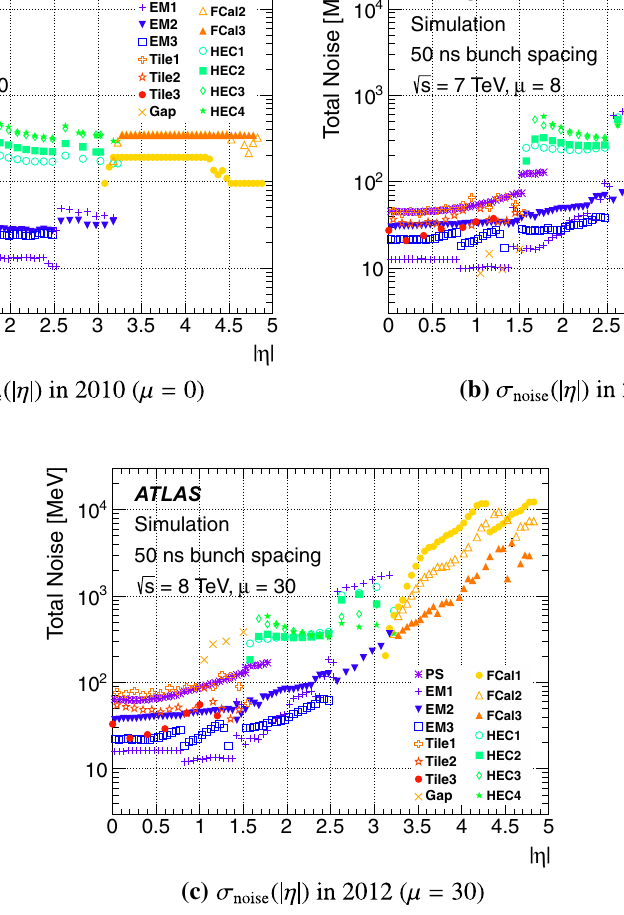
Fig. 4 The energy-equivalent cell noise in the ATLAS calorimeters on the electromagnetic (EM) scale as a function of the direction | η | in the detector, for a the 2010 configuration with μ = 0, b the 2011 configura- tionwith μ = 8(bothplotsfromRef.[16]),and c the2012configuration